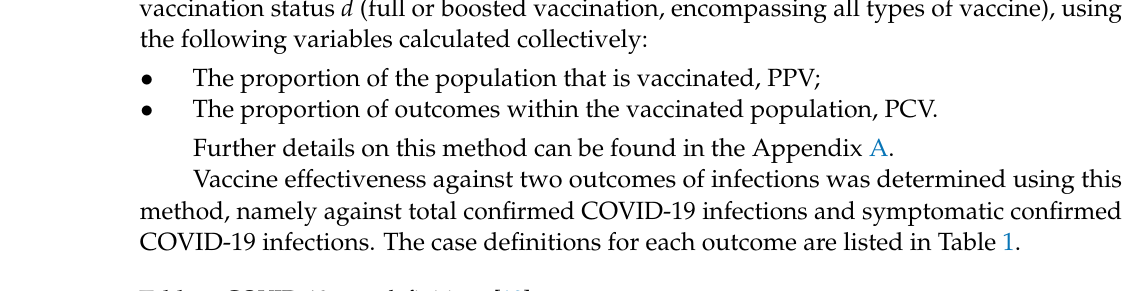
Table 1. COVID-19 case definitions